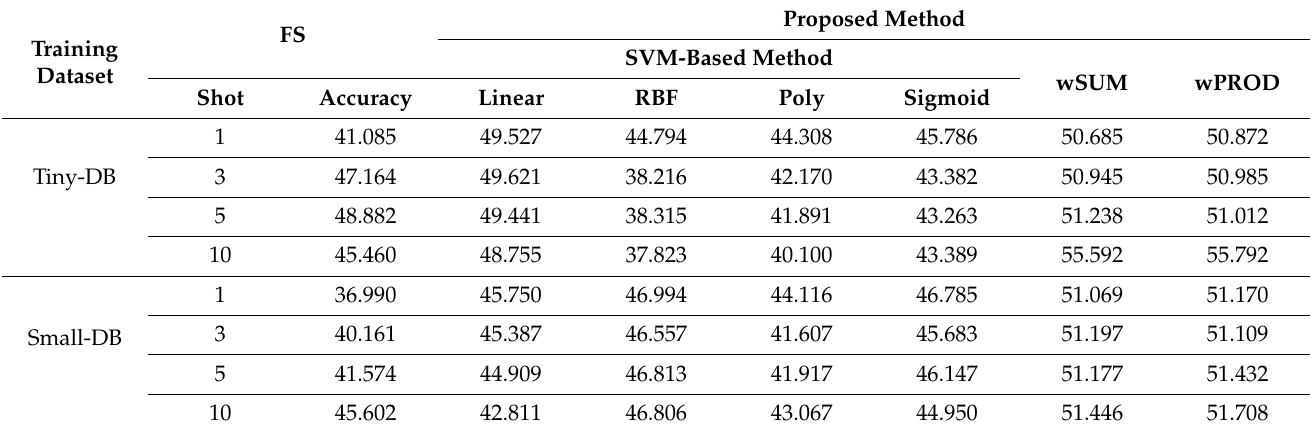
Table 10. Classification performance of FS and the proposed method using the BT-Large dataset according to the size of the training data and size of the support set (unit: